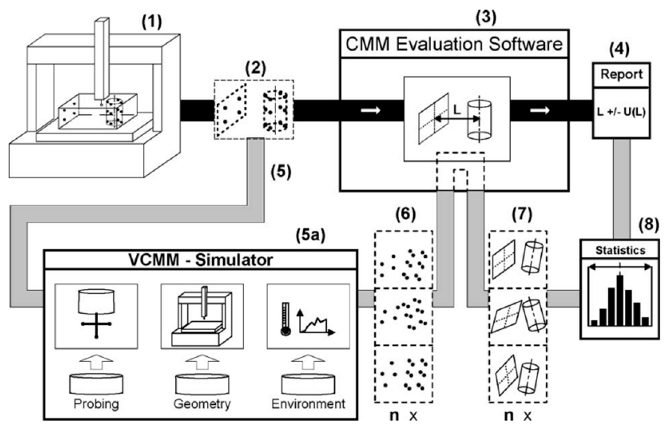
Figure 2. The VCMM approach for coordinate measuring machines [50].